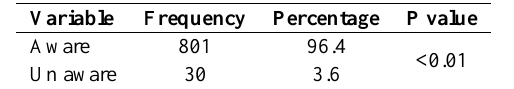
Table 3: Awareness Regarding COVID-19.